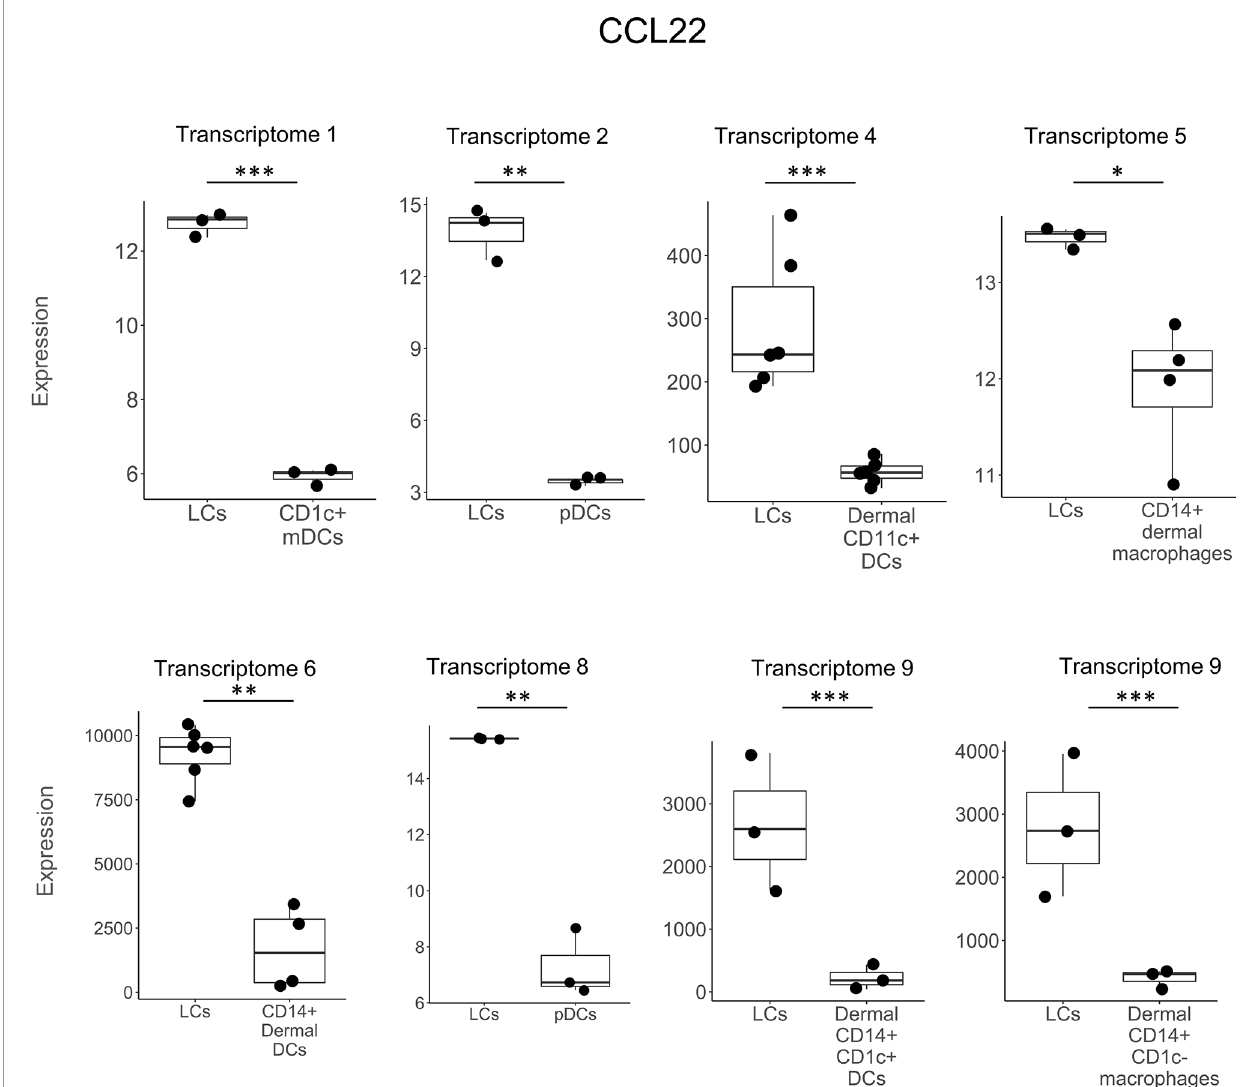
FIGURE 2 | CCL22 expression in LCs vs other DC subtypes. CCL22 was preferentially expressed in LCs vs other DC types in 7 out of the 9 transcriptomes in a total of 8 instances. CCL22 was the most frequently detected gene in transcriptomes and was also previously reported in LCs in non-transcriptome experiments in the literature. *p < 0.05, **p < 0.01, ***p <